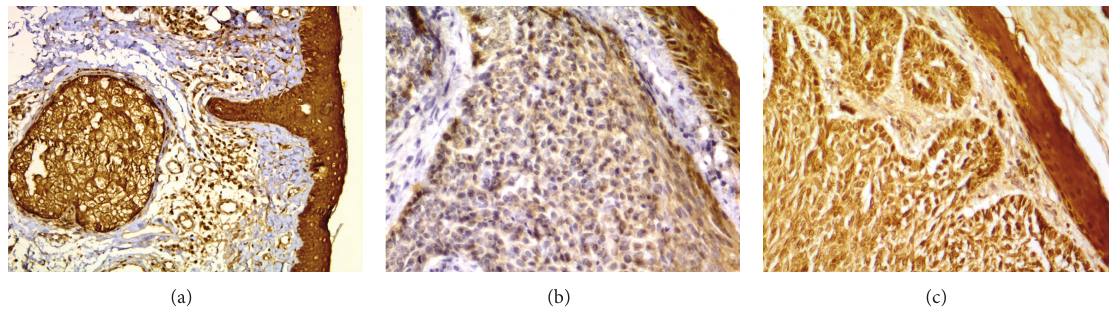
Figure 1: Maspin immunoreactivity in periocular basal cell carcinoma (immunohistochemical staining × 400 for (a), (b), and (c)): (a) strong maspin immunoreactivity in the epidermis and sebaceous gland in one of the control cases, (b) weak maspin immunoreactivity, and (c) moderate maspin